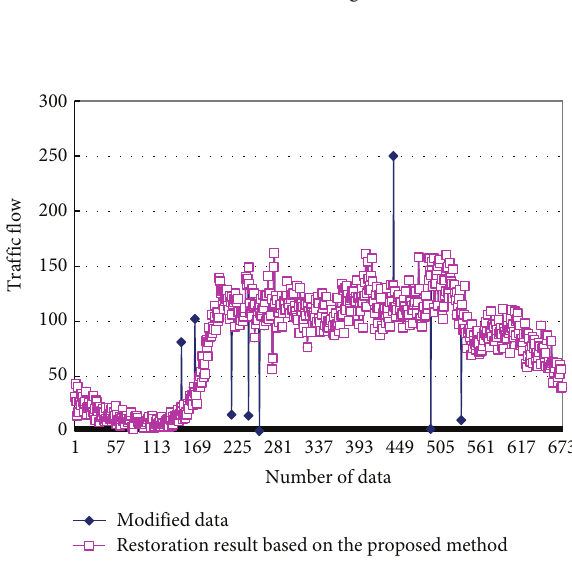
Figure 11: Data comparison before and after restoration.